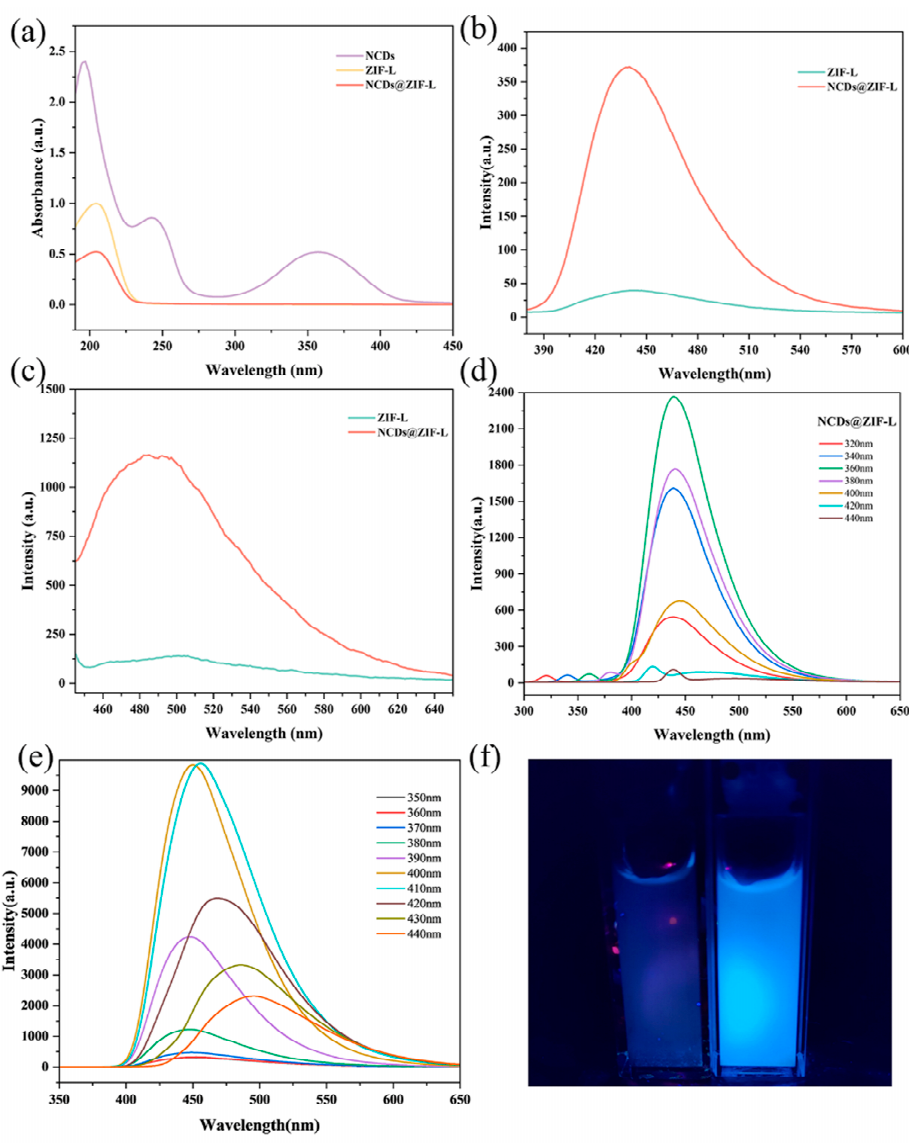
Figure 3. ( a ) UV-Vis absorption of NCDs, ZIF-L, and NCDs@ZIF-L composites. Fluorescence spectra of NCDs, ZIF-L, and NCDs@ZIF-L composites: ( b ) excited at 360 nm and ( c ) excited at 430 nm. Fluorescence spectra of ( d ) NCDs@ZIF-L composites and ( e ) NCDs under various excitation wavelengths. ( f ) ZIF-L and NCDs@ZIF-L composites solutions irradiated by UV